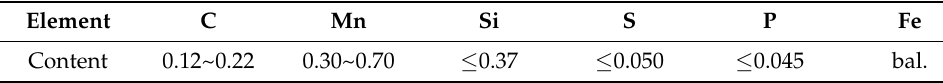
Table 1. Chemical composition of Q235 low carbon steel (wt.%).